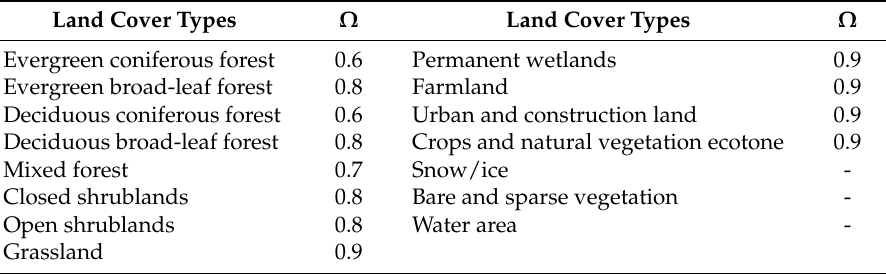
Table 3. The values of Ω of different land cover types.